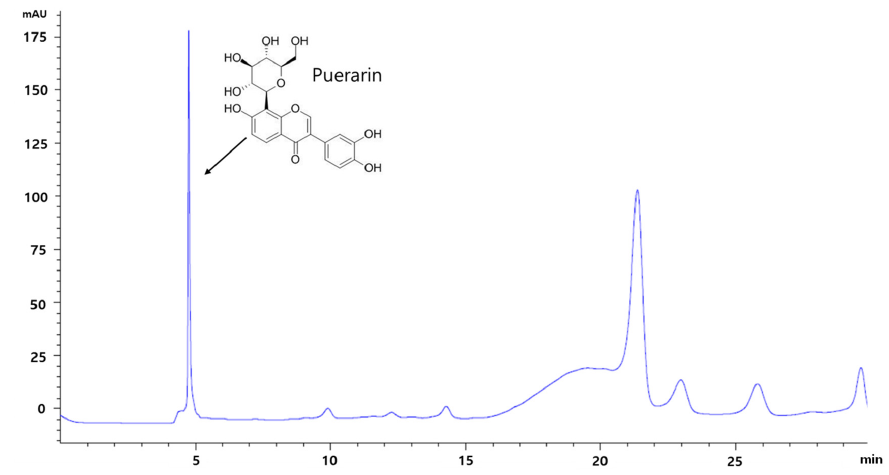
Figure 1. The pattern of puerarin in RP extract by HPLC analysis. RP, Radix Pueraria lobata ; HPLC, High Performance Liquid Chromatography.